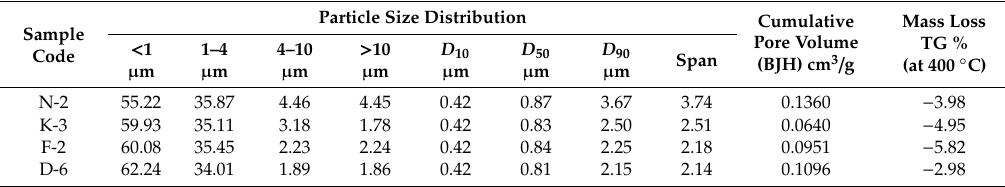
Table 3. Particle size distribution, porosity and moisture content by TG (mass loss % within the temperature range 25–400 ◦ C) of the studied kaolin powder samples.